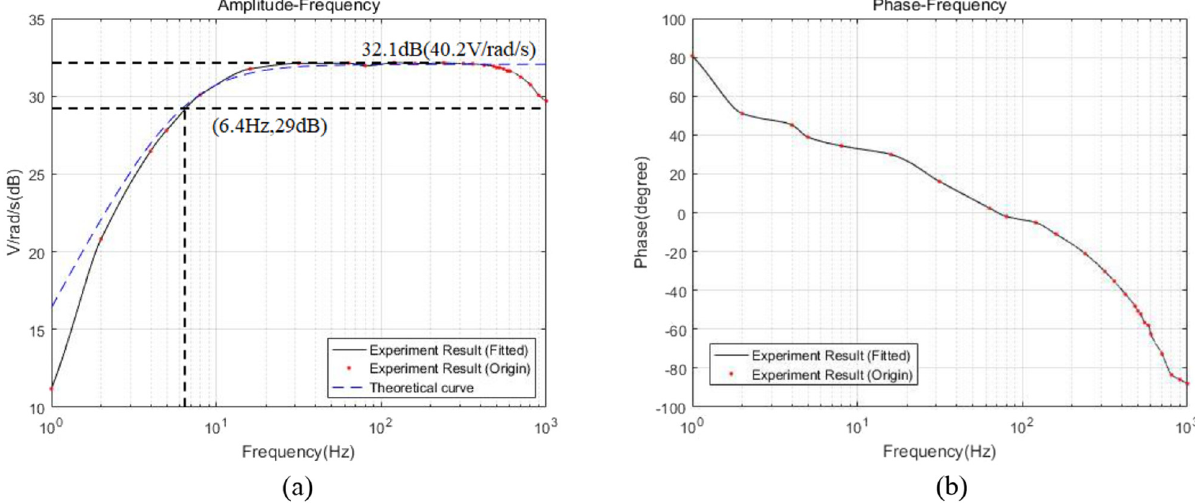
Fig. 8. Frequency characteristics of MHD sensor prototype in experiment. (a) Amplitude-Frequency; (b)